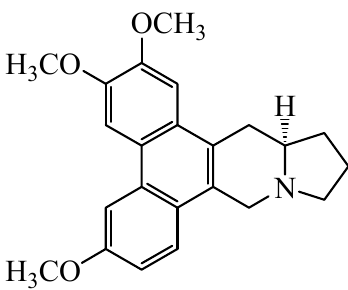
Figure 1. Structure of 7-Demethoxytylophorine (DEM).